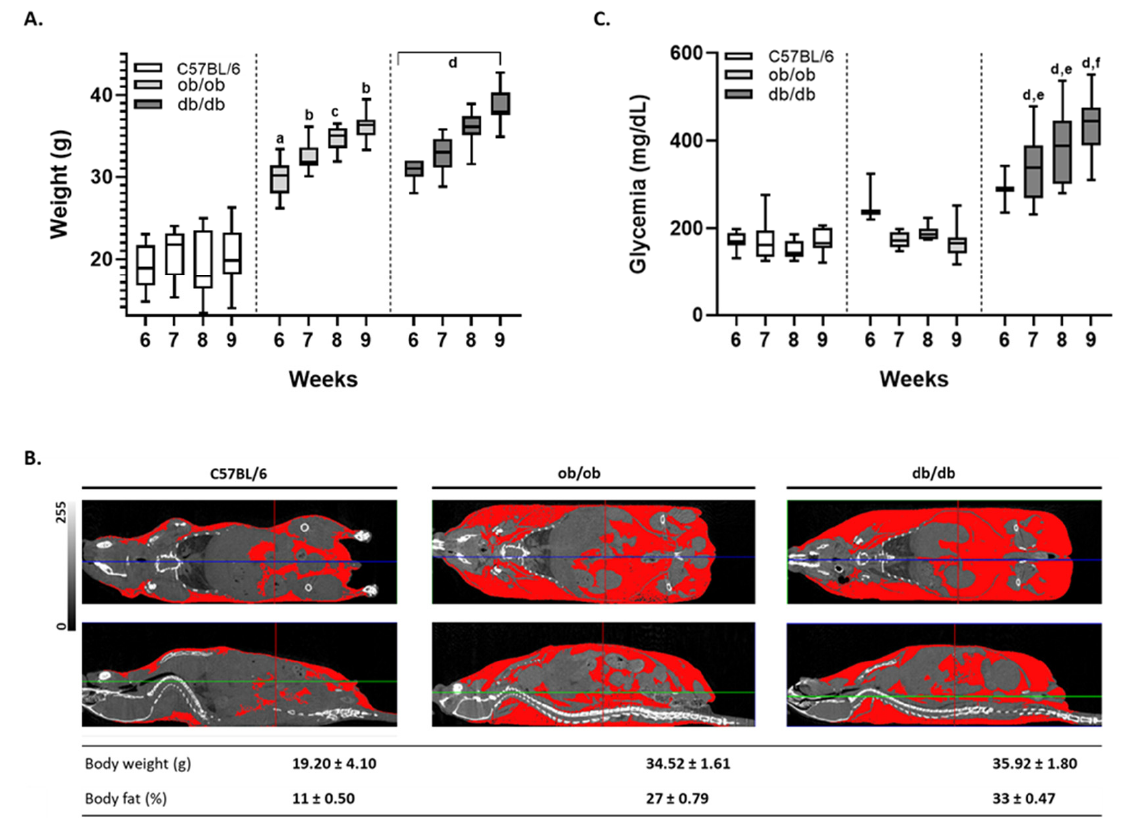
Figure 1. Only db/db animals presented sustained hyperglycemia despite both transgenic models developed the same levels of obesity. Follow up of the animal phenotype from 6 to 9 weeks of age. ( A ) Body weight comparison between C57BL/6J, ob/ob, and db/db animals, along time, maintained on a standard ad libitum diet. ( B ) Micron-scale computed tomography of 8-week-old C57BL/6J, ob/ob, and db/db animals. Representative images of coronal (upper panels) and sagittal (lower panels) orientations. Adipose tissue is highlighted in red, and the table depicts the percentage of body fat for the three animal strains. The grayscale indicates areas of density between 0 and 255 HU on the micro-CT slices shown. Coloring grids displayed are guides for anatomical comparison. ( C ) Time-dependent non-fasting blood glucose levels of C57BL/6J, ob/ob, and db/db models. Shown are the values of 18 age-matched control (white), ob/ob (light gray), and db/db (dark gray) animals, per time-point. Box-and-whisker plot represented by 25th and 75th quartiles, line within the box denotes the median, and the whiskers extend from minimum to maximum values. Statistical analyses of the weight and glycemia, across categories, were conducted using the median in the nonparametric Kruskal–Wallis test (a: C57BL/6J vs. ob/ob, p ≤ 0.0001; b: C57BL/6J vs. ob/ob, p ≤ 0.001; c: C57BL/6J vs. ob/ob, p < 0.05; d: C57BL/6J vs. db/db, p ≤ 0.0001; e: ob/ob vs. db/db, p ≤ 0.01; f: ob/ob vs. db/db, p ≤ 0.0001).